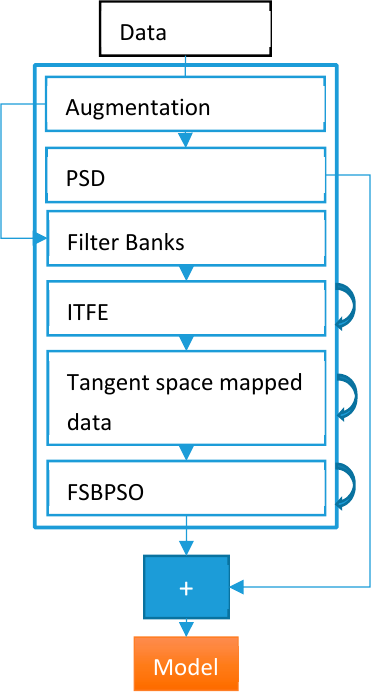
Figure 4. Overall architecture of the proposed method, where the curved arrows represent the algorithms which have two modes; that is, for training and testing.